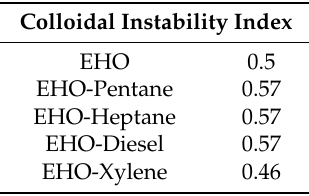
Table 3. Colloidal instability index (CII) determined for the extra-heavy oil (EHO), and its mixtures with different diluents at a fixed dosage of 5 vol %.